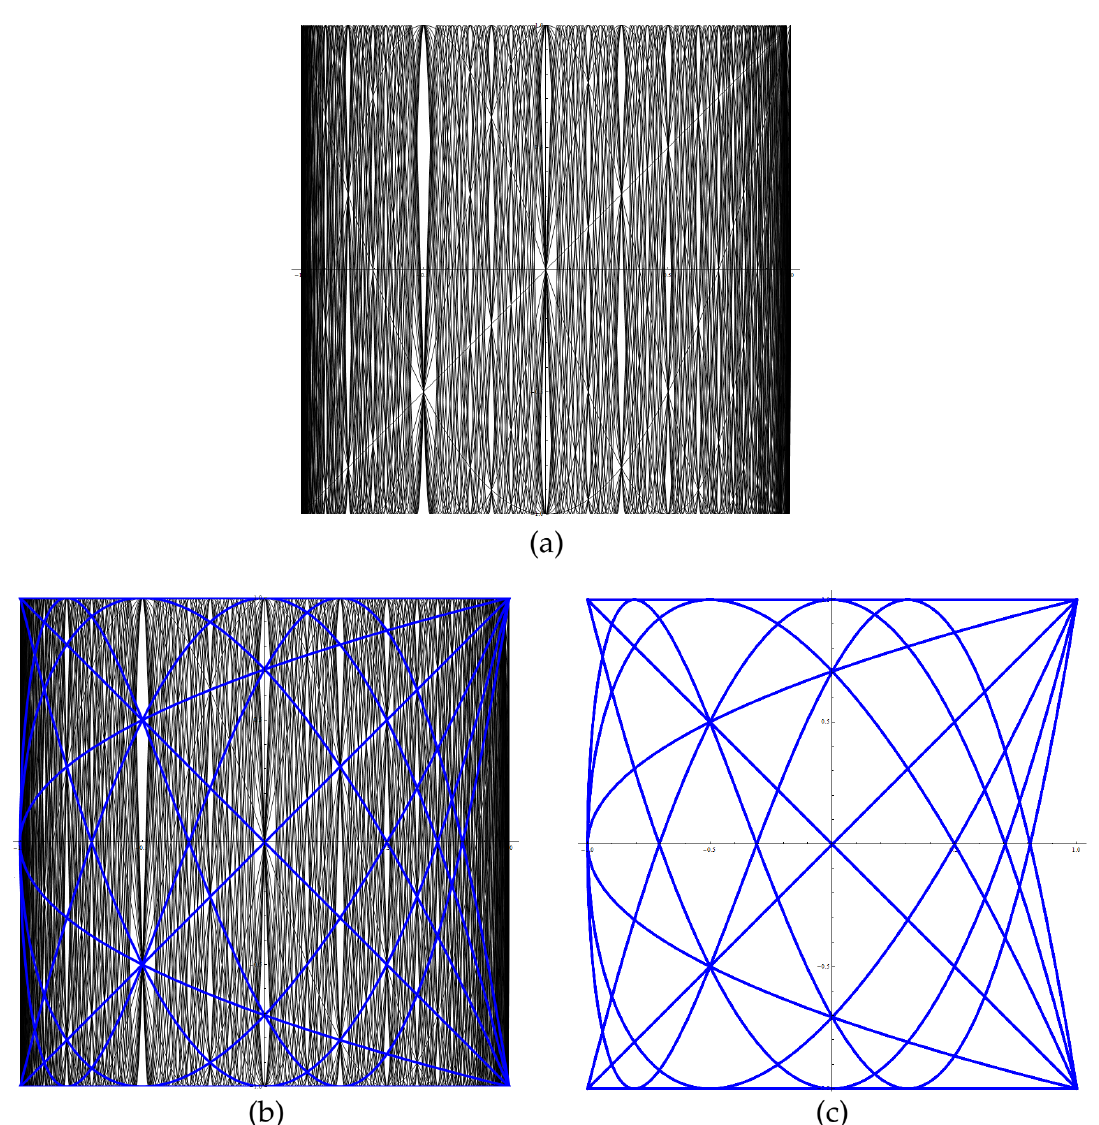
Figure 1. The first 6 white curves. Figure ( a ) shows the original version—the white curves are visible in the background of the plot of the first 35 Chebyshev’s polynomials. On ( b ) the white curves are coloured blue, on ( c